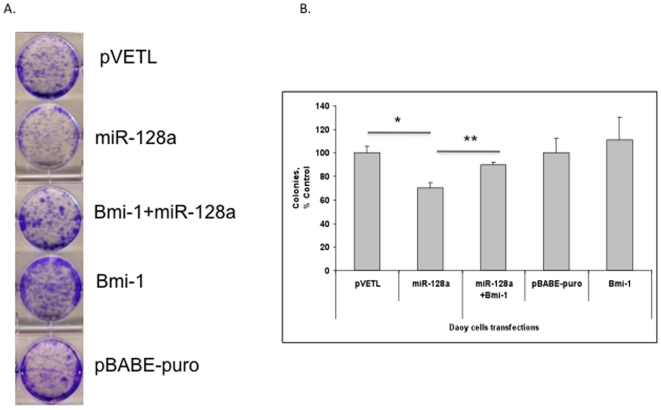
Bmi-1 rescues miR-128a mediated growth arrest of medulloblastoma cells.A) Co-transfection of Daoy cells with miR-128a and Bmi-1 increased the number of colonies formed compared to that of miR-128a alone. B) Quantitative analysis of the number of colonies formed by Daoy cells after different transfections, including Bmi-1 that lacks its 3′UTR. pBABE-puro is a control vector for the full length Bmi-1. *p<0.05 for miR-128a vs. pVETL and **p<0.001 for miR-128a vs. miR-128a + Bmi-1.